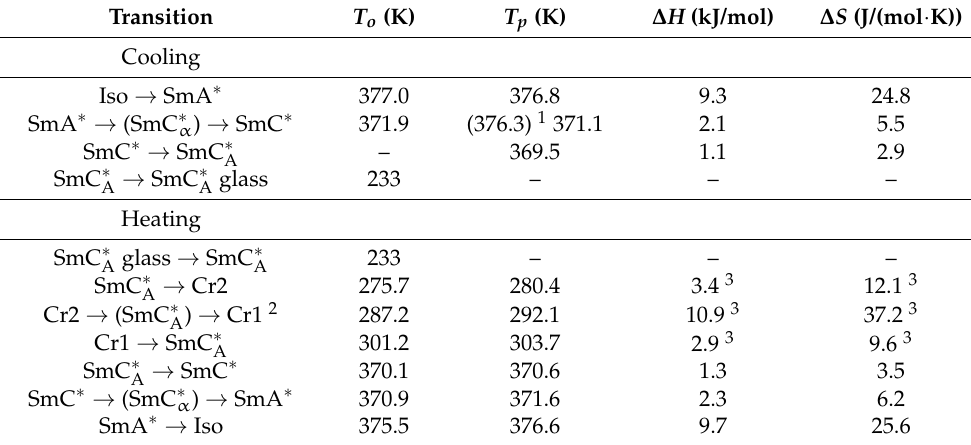
Figure 2. DSC curves of 3F7FPhH6 registered at the 2 K/min rate ( a ) and 5–20 K/min rates ( b ). The insets in (a) show the enlarged parts of the DSC curves for the 2 K/min rate close to the clearing temperature. Table 1. Phase transition temperatures (onset temperature T o and peak temperature T p ) and energy effects (enthalpy change ∆ H and entropy change ∆ S = ∆ H / T p ) determined from the DSC results for the 2 K/min